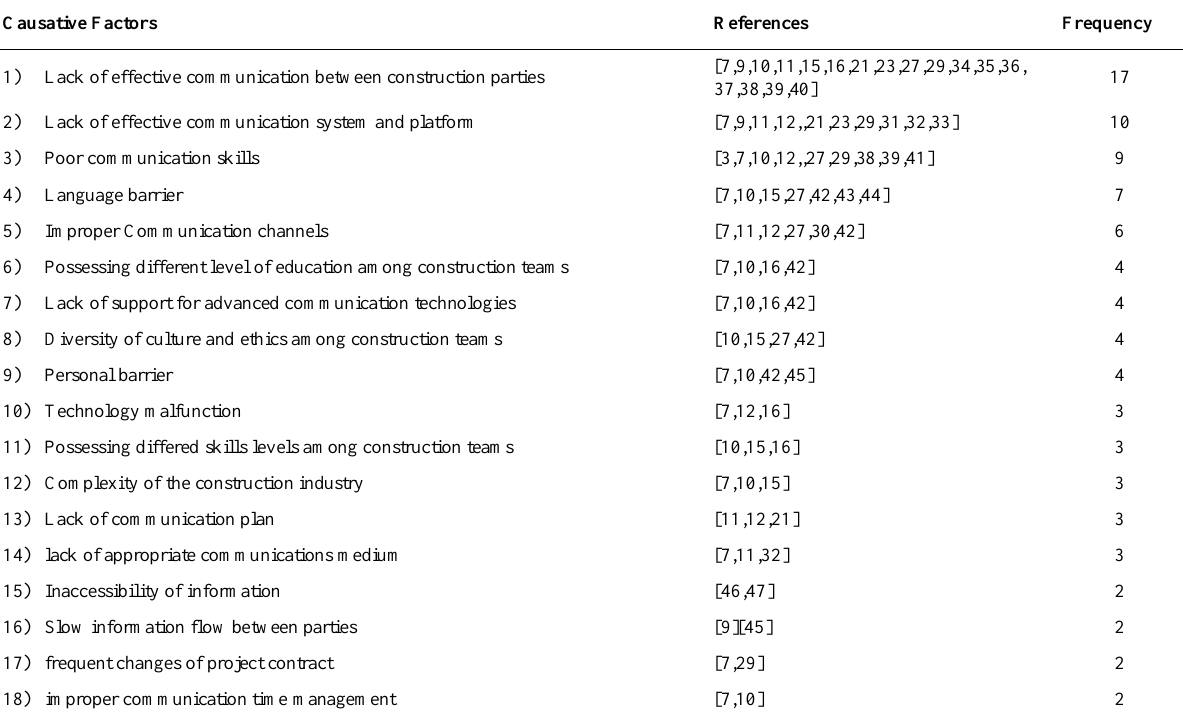
Table 2. Matrix of Causative Factors of Poor Communication and Their